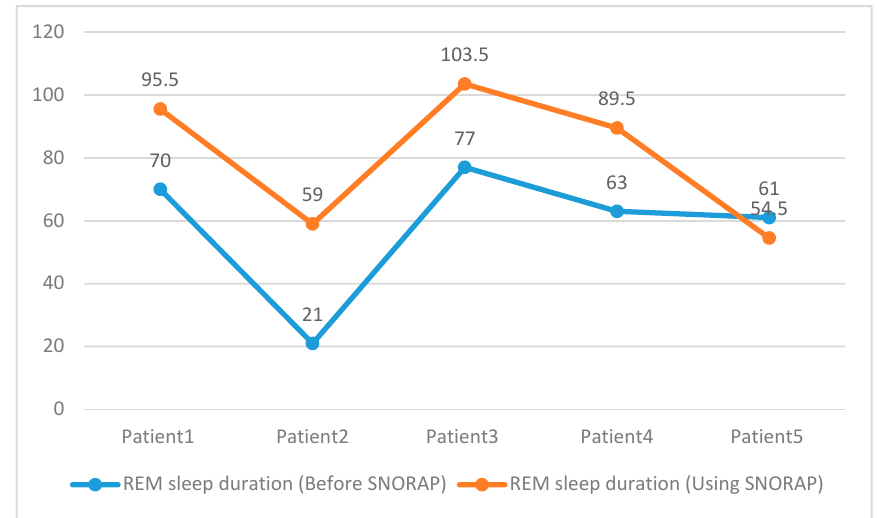
Figure 11. Rapid Eye Movement Sleep duration.